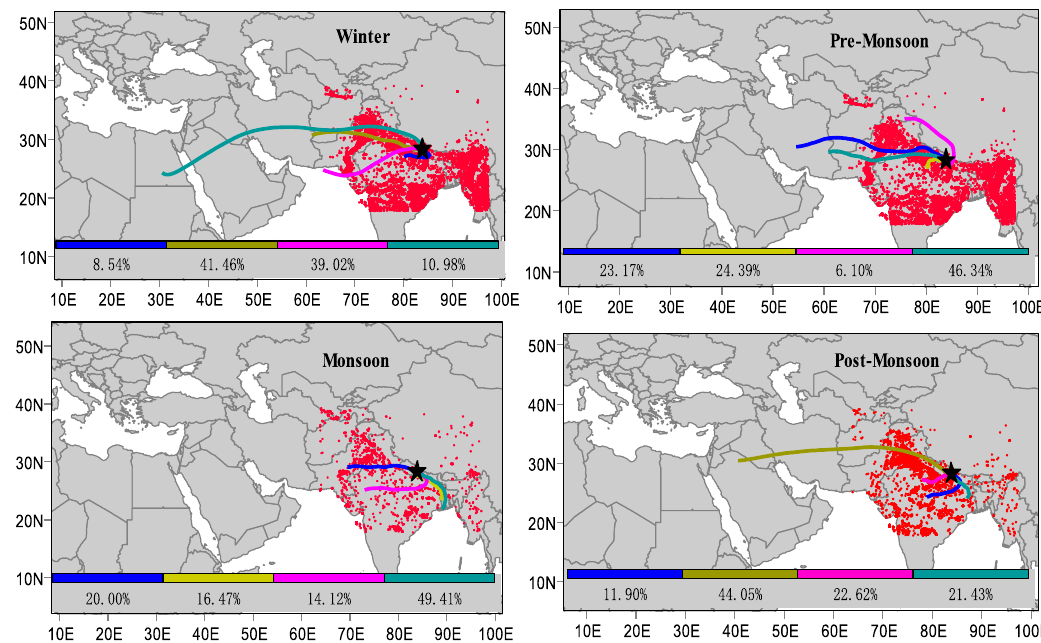
Figure 8. Clusters of five days air mass back trajectories computed with HYSPLIT model reaching Pokhara and at altitude 500 m and all active fire spots; each season is symbolized with red dots at different seasons (winter, pre-monsoon, monsoon and post-monsoon) of 2017. The percentage contributions of each cluster are shown in different colors.